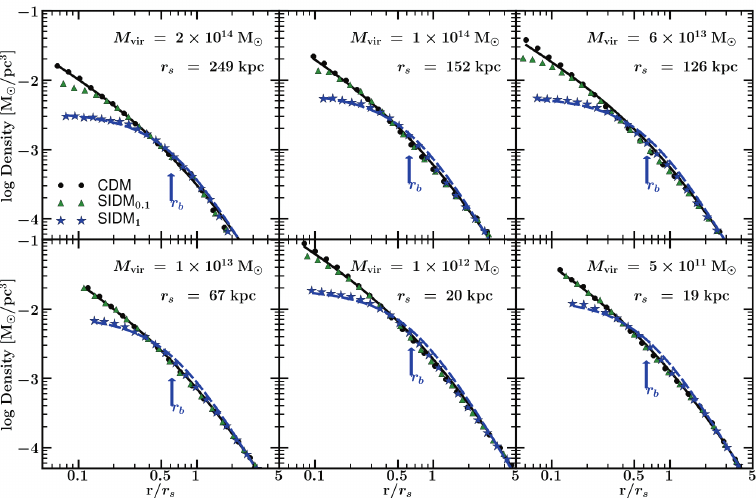
Figure 10. Comparison of the NFW (black line) and Burkert (blue line) density profiles with simulations of SIDM universes, using the two cross section over DM particle masses σ / m = 1 and 0.1, denoted SIDM 1 (blue stars) and SIDM 0.1 (green triangles) respectively. The arrow indicated the location of the Burkert’s profile core radius (figure reproduced from